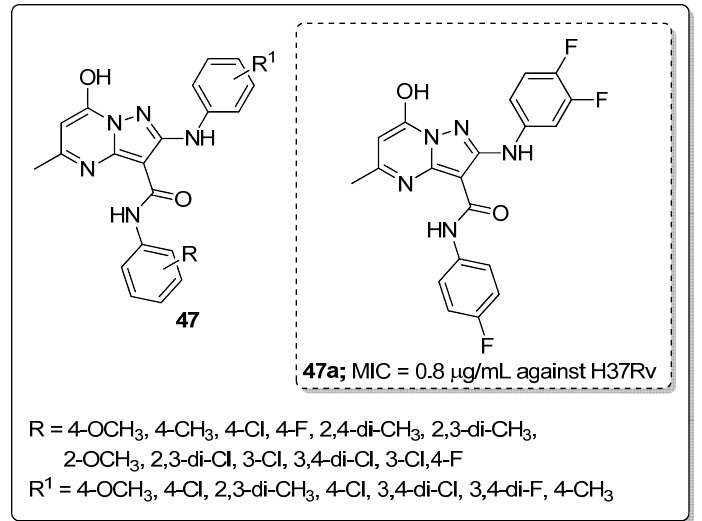
Figure 54. The antitubercular activity of the most active pyrimidine ‐ fused pyrazole hybrid 47a .